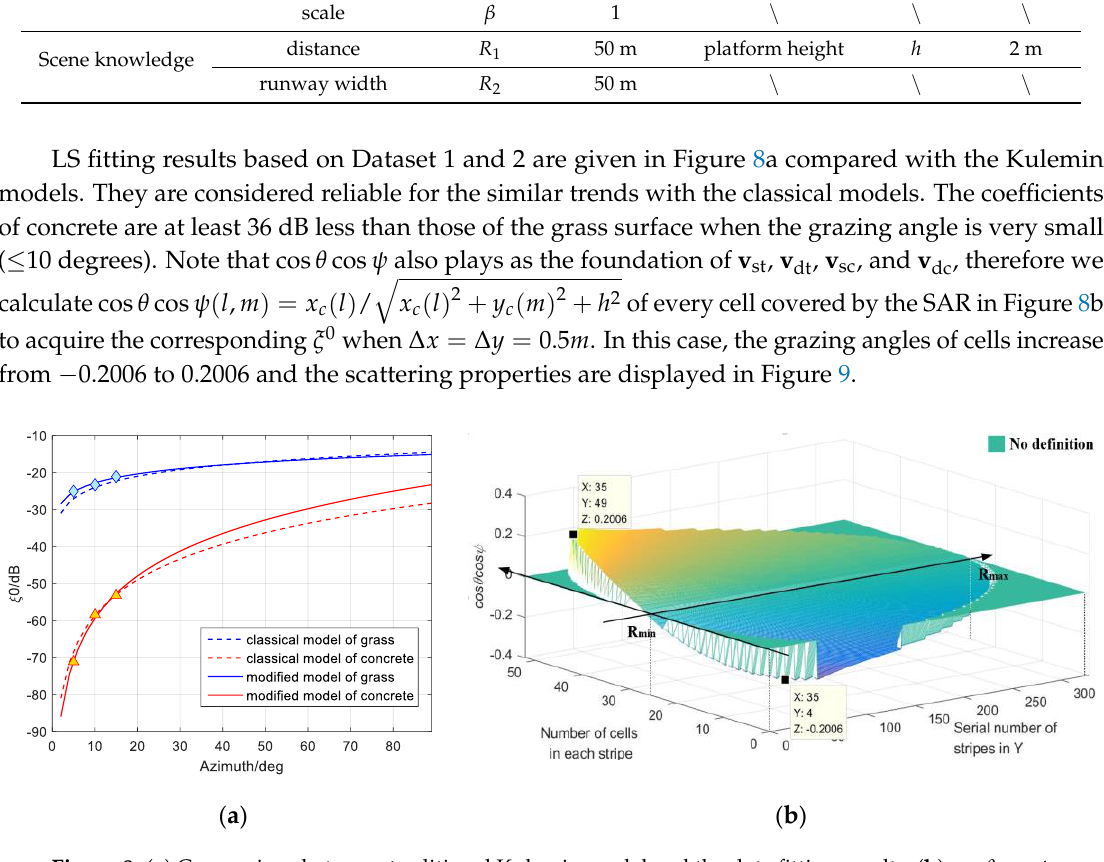
Figure 9. Scattering properties within the radar coverage, on basis of the parameter-modified models in Figure 8a when the cell size is 0.5 m × 0.5 m.